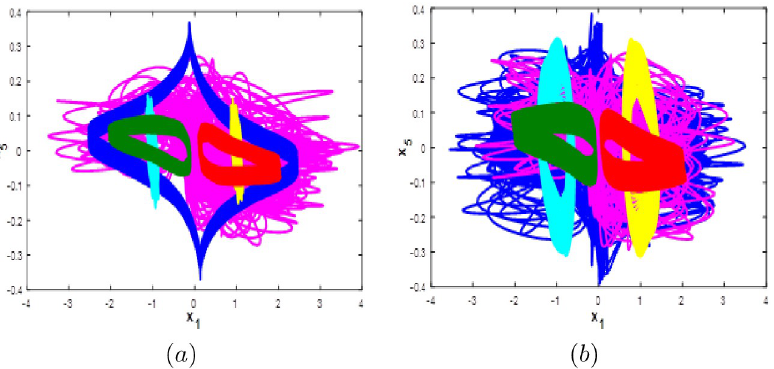
Fig 12. Coexistence of six different attractors projected on the x 1 − x 5 plane. (a) Coexistence of one hyperchaotic attractor and five quasi-periodic attractors when a = 0.01. (b) Coexistence of two hyperchaotic attractors and four quasi-periodic attractors when a = 0.1.